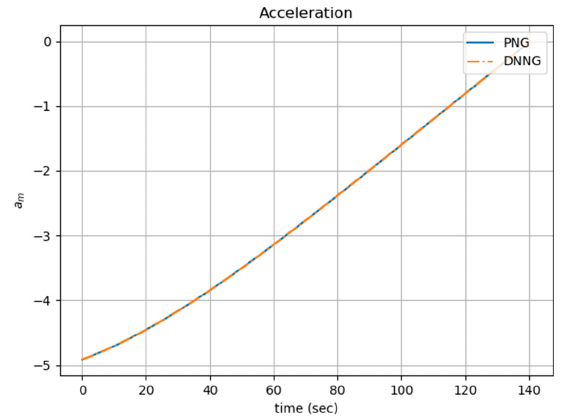
Figure 7. Comparison of the acceleration of PNG and DNNG laws.